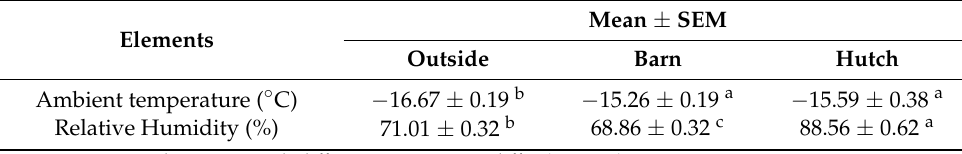
Table 2. Ambient temperature and relative humidity outside and inside the barn and hutches during the